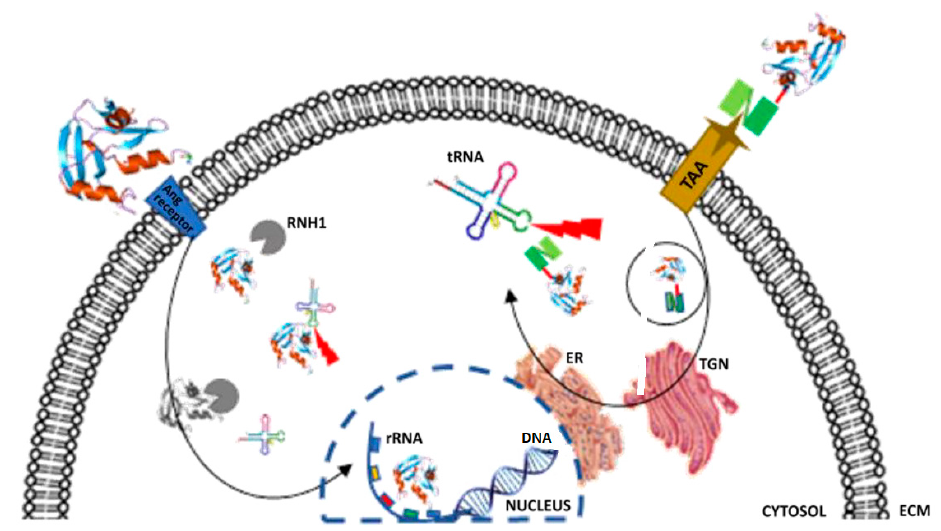
Figure 1. Mechanism of action following targeted Angiogenin delivery to a cell. Angiogenin binds to a membrane receptor (blue wedge), localizes to the nucleus and engages in rRNA processing. Under stress conditions, Ang is found more prolifically in the cytosol, where it degrades tRNA and blocks biosynthesis. An Ang-based hCFP is designed to be selectively internalized via a disease-associated antigen and delivered to the cytosol, where it degrades tRNA similarly to free cytosolic Ang. Both free Ang and immuno-Ang are sensitive to cytosolic RNH1 inhibition.